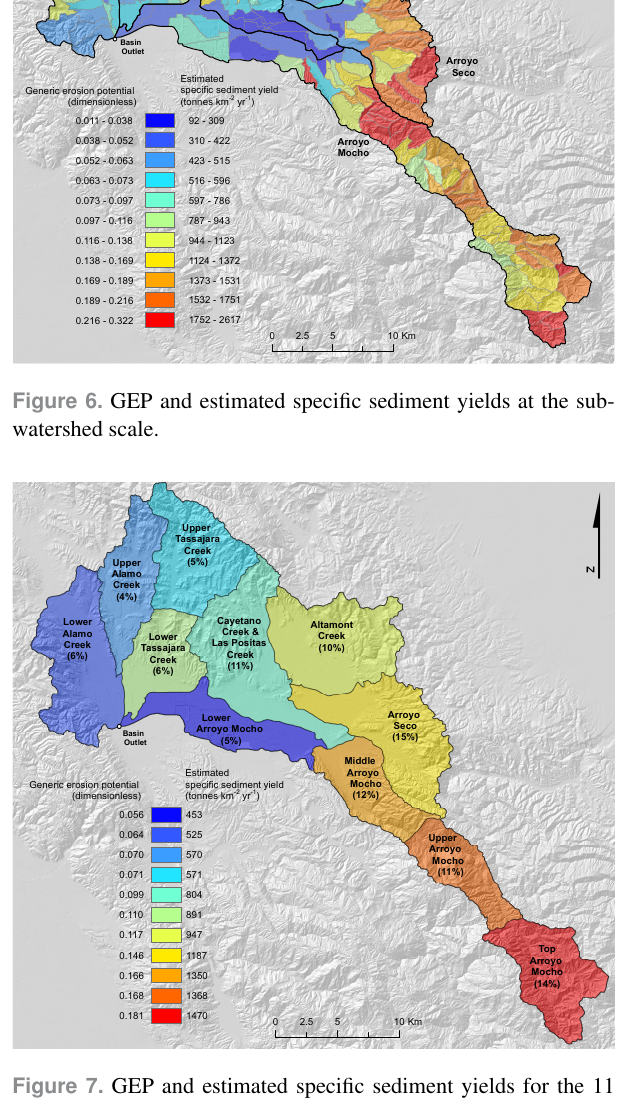
Figure 7. GEP and estimated specific sediment yields for the 11 major basins in the Arroyo Mocho watershed. Values in parentheses are the percentage of the total estimated sediment yield for Arroyo Mocho contributed by each